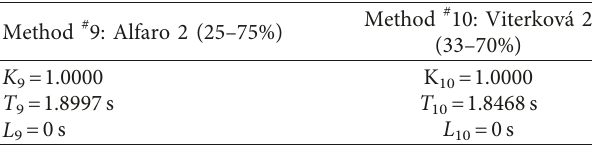
Table 16: DPPDT model parameters obtained using Alfaro’s and Viterkov´a’s two-point methods,